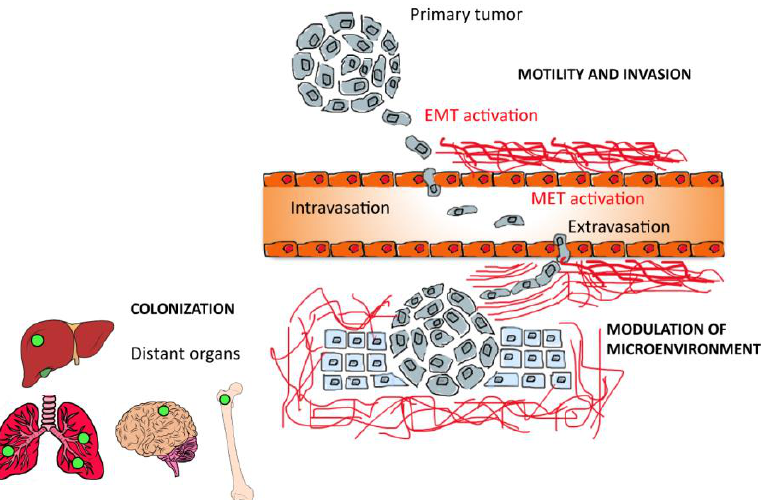
Figure 1. Hallmarks of the metastatic process: Neoplastic cells migrate from the primary tumor and start to invade through surrounding stroma via a multiple motility mechanisms (as single cells via EMT). Single cells once entered into the vasculature (intravasation) roll along the endothelium and selectively adhere to endothelium or stop when the vessel diameter is too small to traverse. Adhesion tumor cells exit vessels (extravasation), the ECM is reorganized and can result in the release of matrikines that affect tumor cell and/or stromal behavior. This activated environment results permissive for proliferation and colonization of secondary sites. Disseminating cells selectively colonize several tissues and the process of further dissemination (i.e., metastasizing from metastases) can occur.